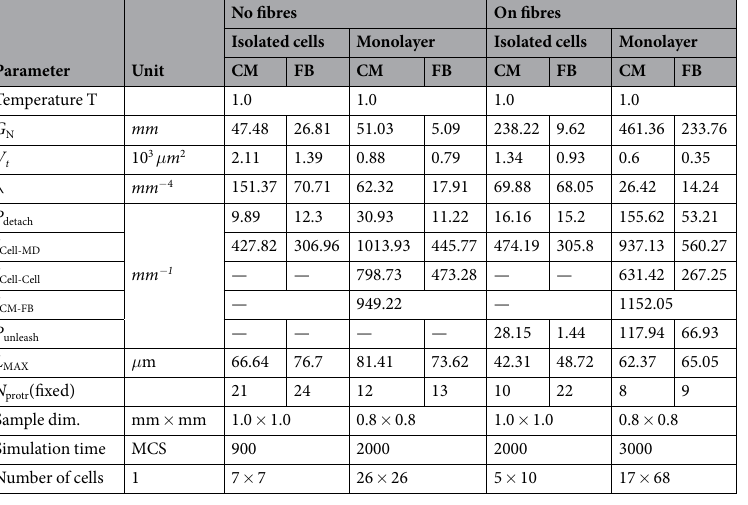
Table 2. Parameters of the